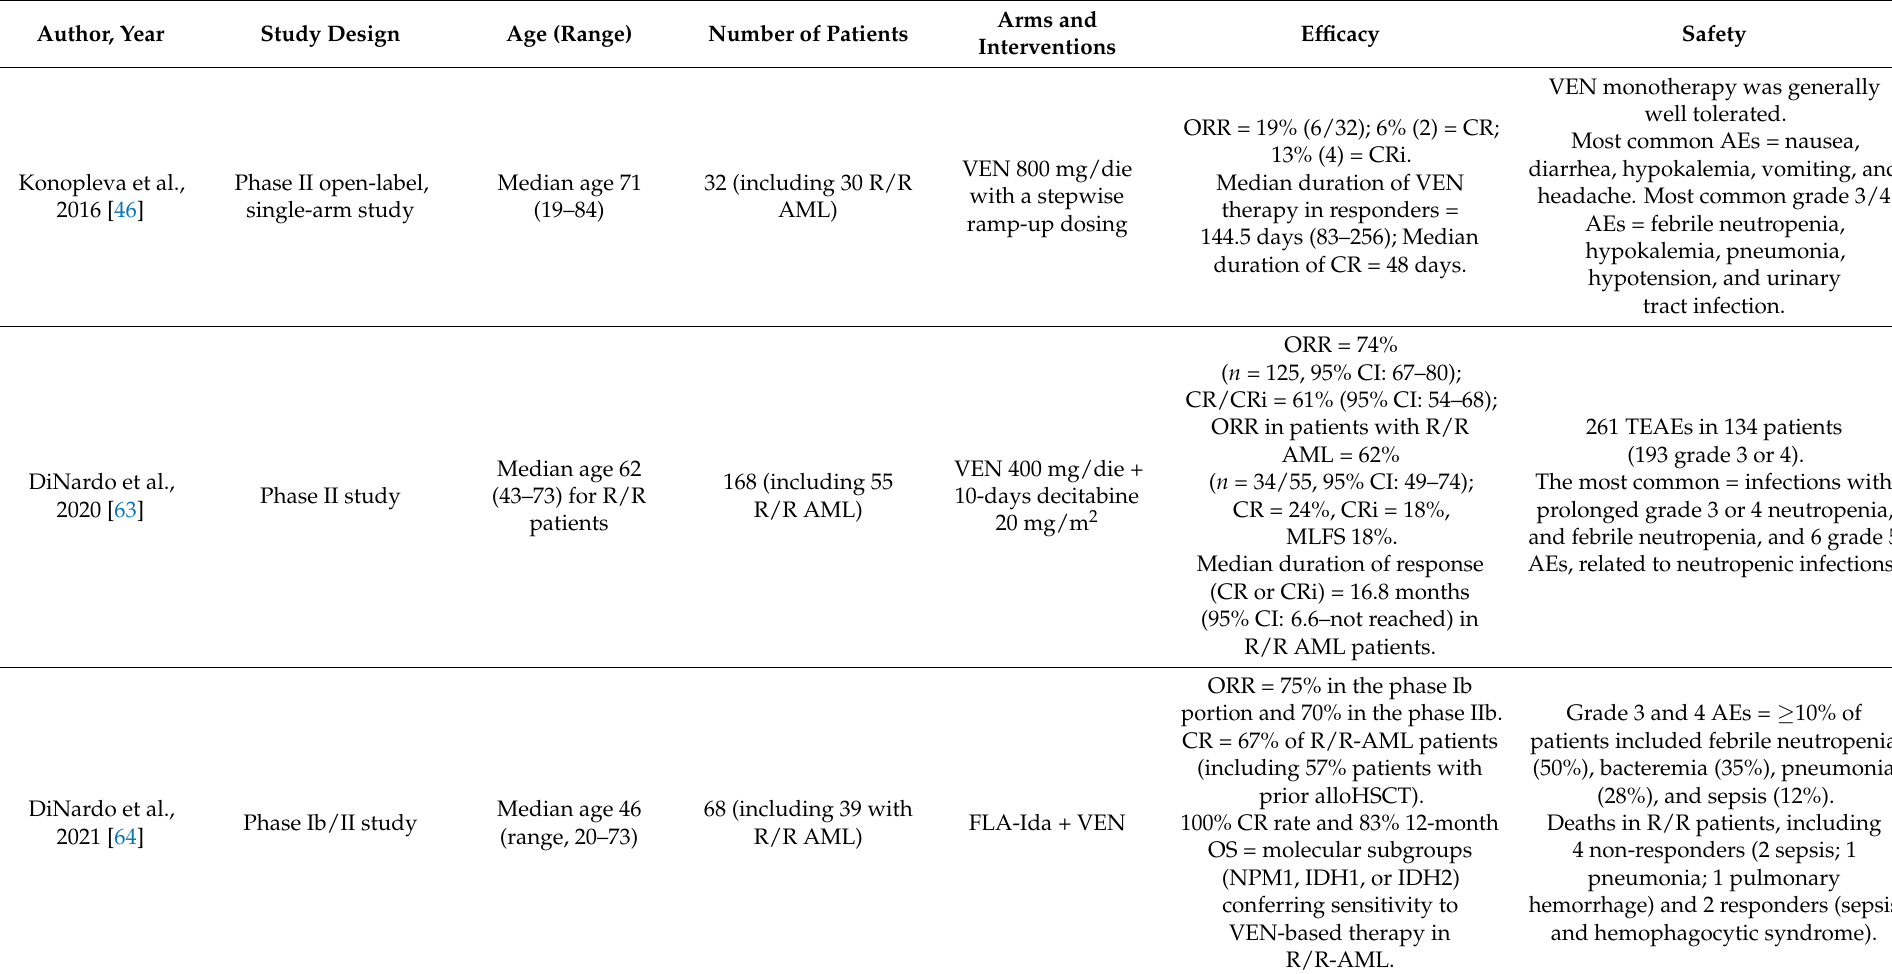
Table 1. Main efficacy and safety results from clinical trials and observational